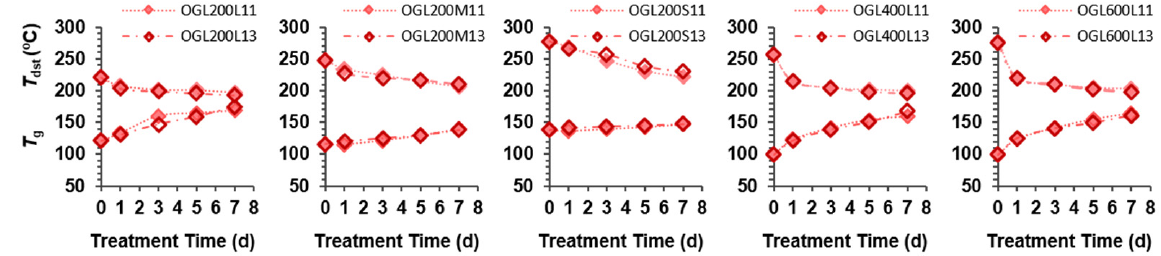
Figure 8. Thermal properties, including T g and T dst , of OGLs as a function of H 2 O 2 treatment time.